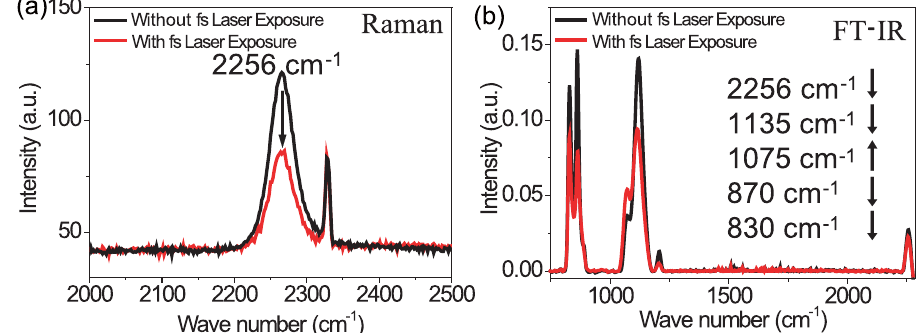
Fig. 3 Femtosecond (fs) laser exposure induced change in Raman and FT-IR spectra of HSQ. a Raman spectra of HSQ fi lm before (black) and after (red) fs laser exposure. b FT-IR spectra of HSQ fi lm before (black) and after (red) fs laser